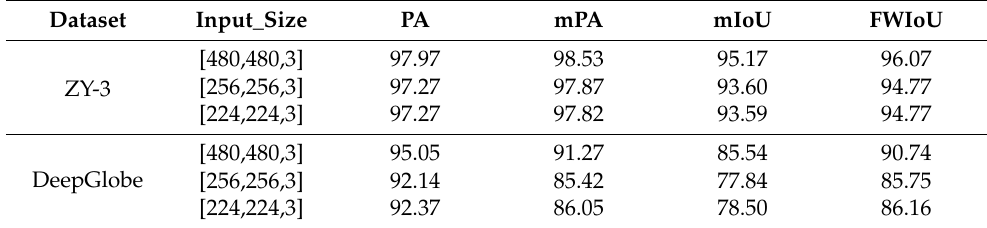
Table 5. The results of the experiment regarding the input size (%).